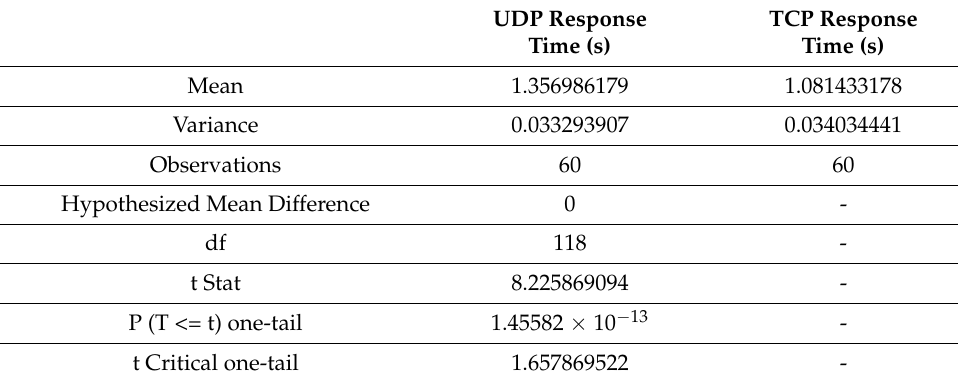
Table 11. Result, Experiment 8.